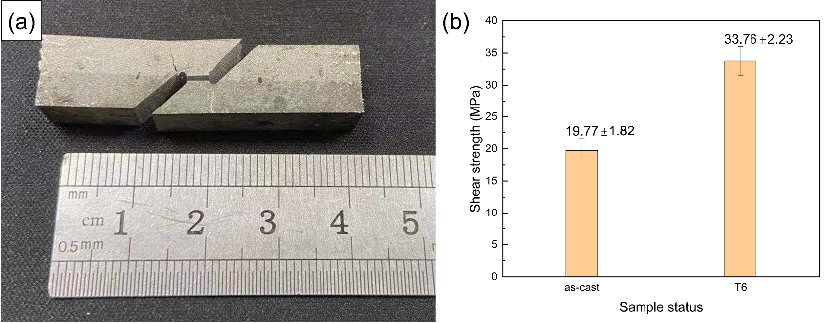
Figure 21. Macrograph of fractured shear test specimen ( a ) and shear strength of the solid–liquid bonding interface ( b ).